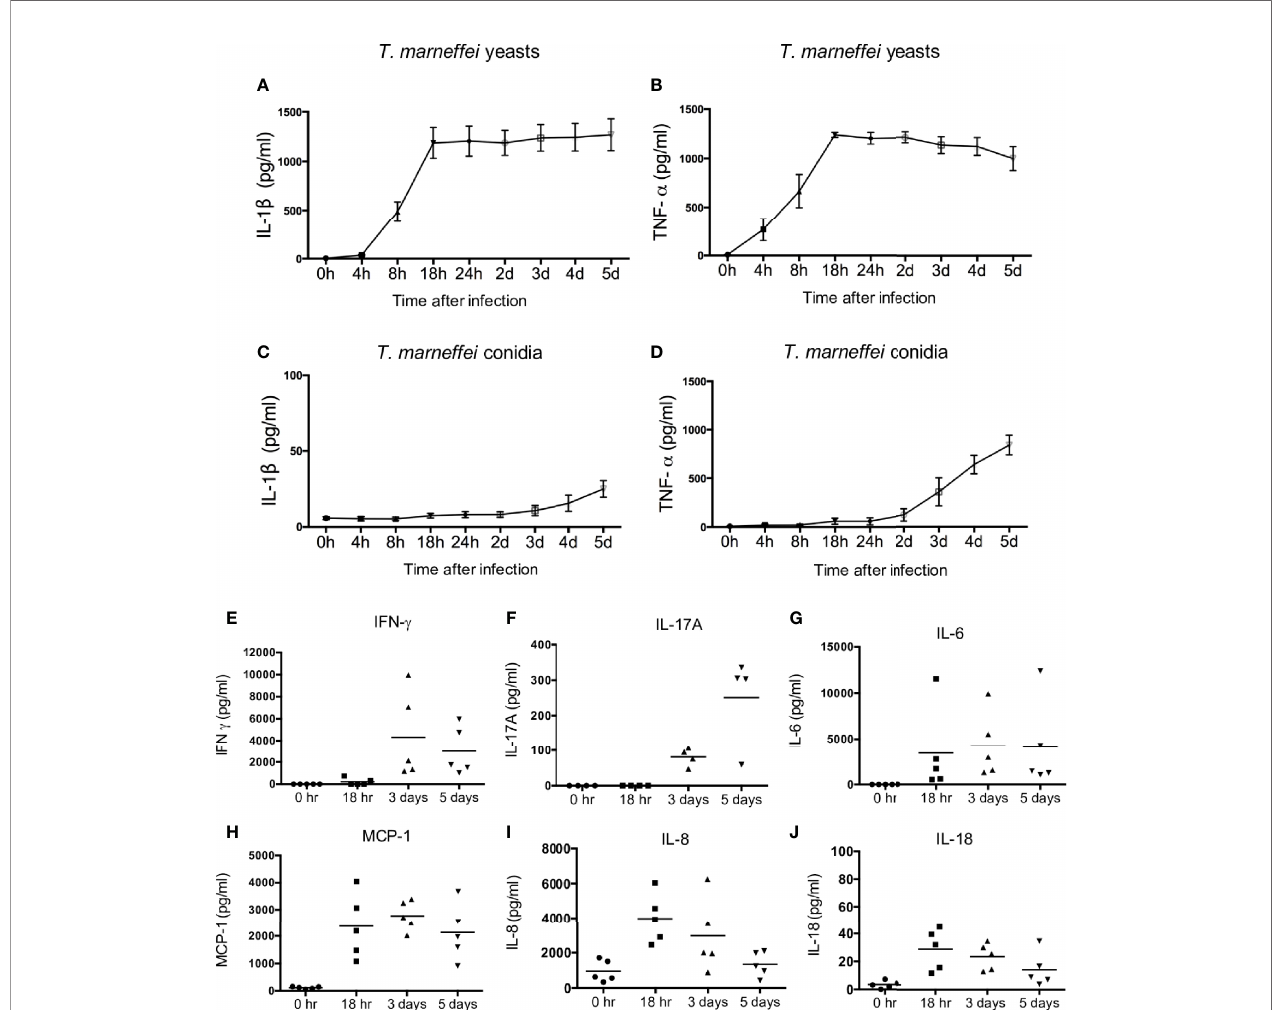
FIGURE 1 | T. marneffei yeasts, but not conidia, induce potent IL-1 b response in human PBMCs. (A, B) Quanti fi cation of IL-1 b and TNF- a by ELISA in human PBMCs (4x10 6 /ml) infected with live T. marneffei yeasts (0.5 MOI) for indicated time points (n=5, mean ± SEM). (C, D) ELISA detection of IL-1 b and TNF- a in human PBMCs (4x10 6 /ml) infected with live T. marneffei conidia (0.5 MOI) for indicated time points (n=5, mean ± SEM). (E) Quanti fi cation of IFN- g by LEGENDplex ™ in human PBMCs (4x10 6 /ml) infected with live T. marneffei yeasts (0.5 MOI) for indicated time points (n=5). (F) Quanti fi cation of IL-17A by ELISA in human PBMCs (4x10 6 /ml) stimulated with heat-killed T. marneffei yeasts (0.5 MOI) for indicated time points (n=4). (G ‒ J) Quantitative analyses of cytokines by LEGENDplex ™ in human PBMCs (4x10 6 /ml) infected with live T. marneffei yeasts (0.5 MOI) for indicated time points (n=5). “ h ” and “ d ” denote “ hours ” and “ days ” (A ‒ D) , respectively. Each symbol represents one healthy donor (E ‒ J)